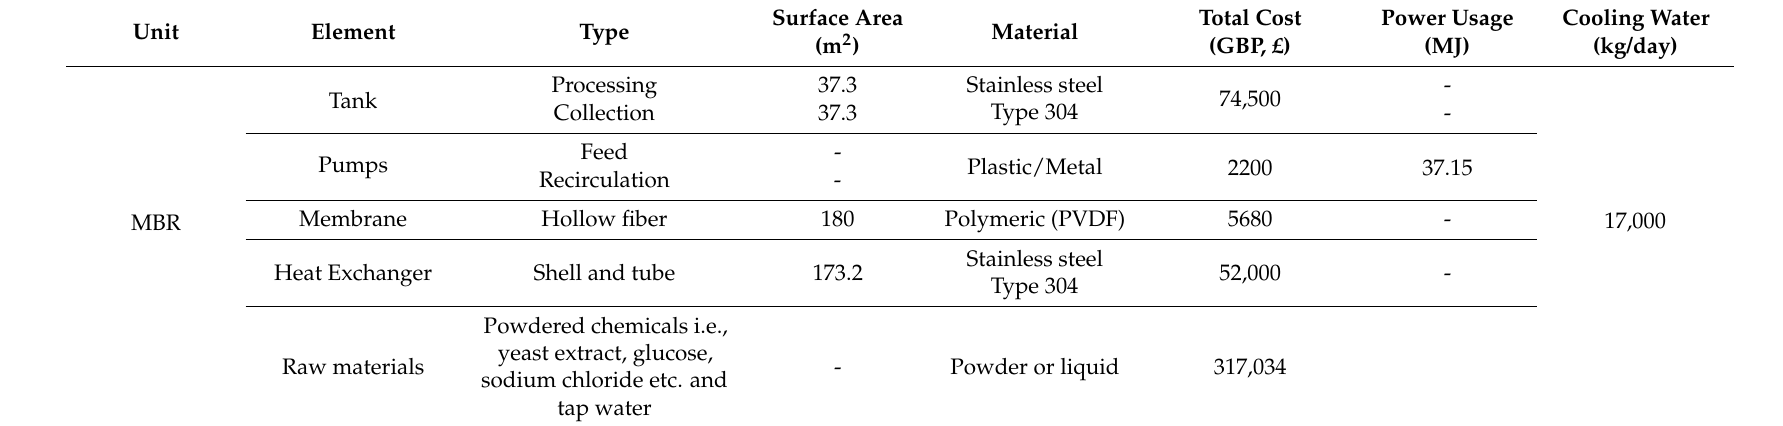
Table 3. Major equipment specification and purchase cost (based on 2018) to obtain 220 m 3 /d of media [51].